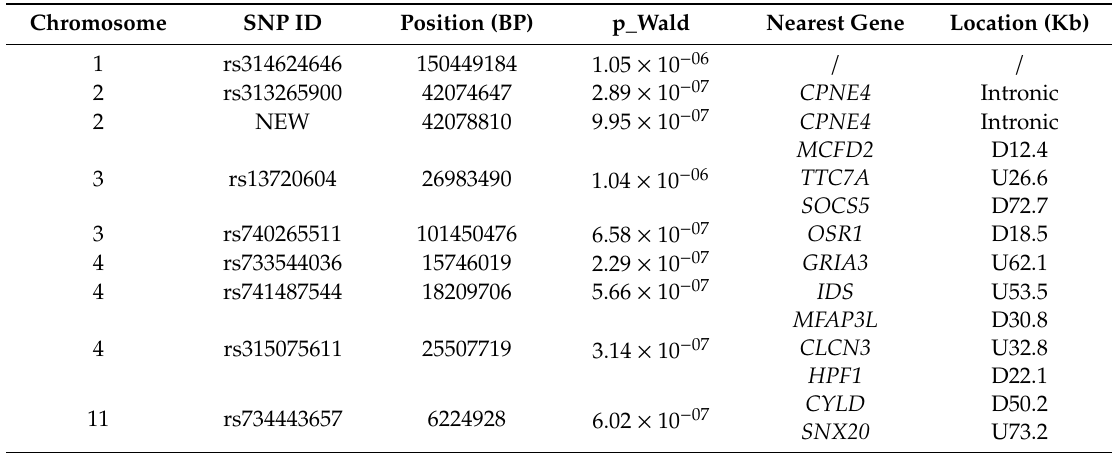
Table 1. SNPs with genome-wide significance for muscle